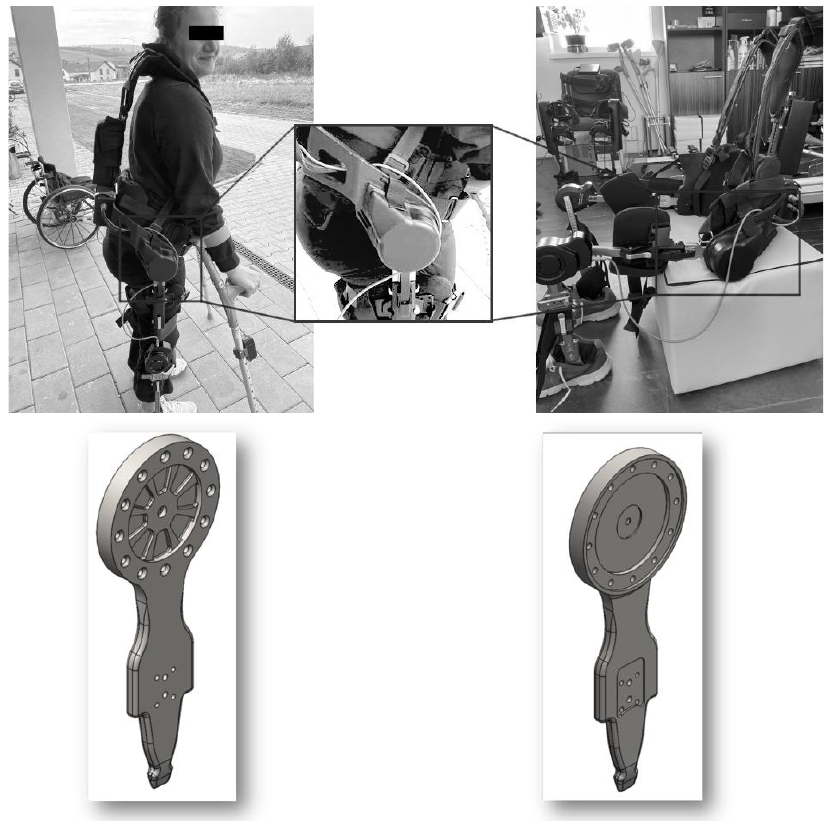
Figure 1. The exoskeleton and the tested junction piece.